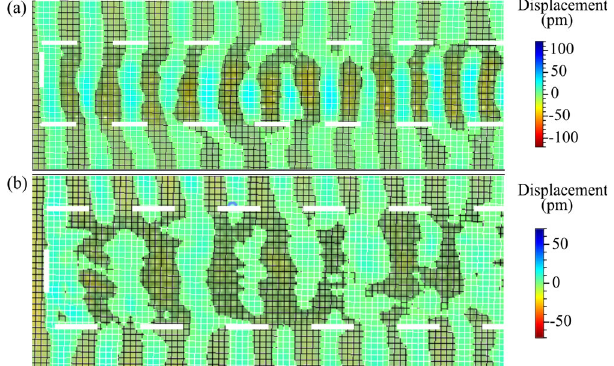
Fig. 6 Experimental out-of-plane ( z ) displacement data obtained from LDV measurements. LDV measurements taken from a the ‘ slow SAW ’ array (Array#1) and b the ‘ fast SAW ’ array (Array#2) at the transducer frequency of 97 MHz. The white dashed lines represent the approximate array region within the analysed LDV aperture area. Measurements were taken within the array and also in the unpatterned surroundings. In the ‘ slow SAW ’ array a SAW wavefronts lag behind the wavefronts in the unpatterned surroundings and in the ‘ fast SAW ’ array b SAW wavefronts lead the wavefronts in the unpatterned